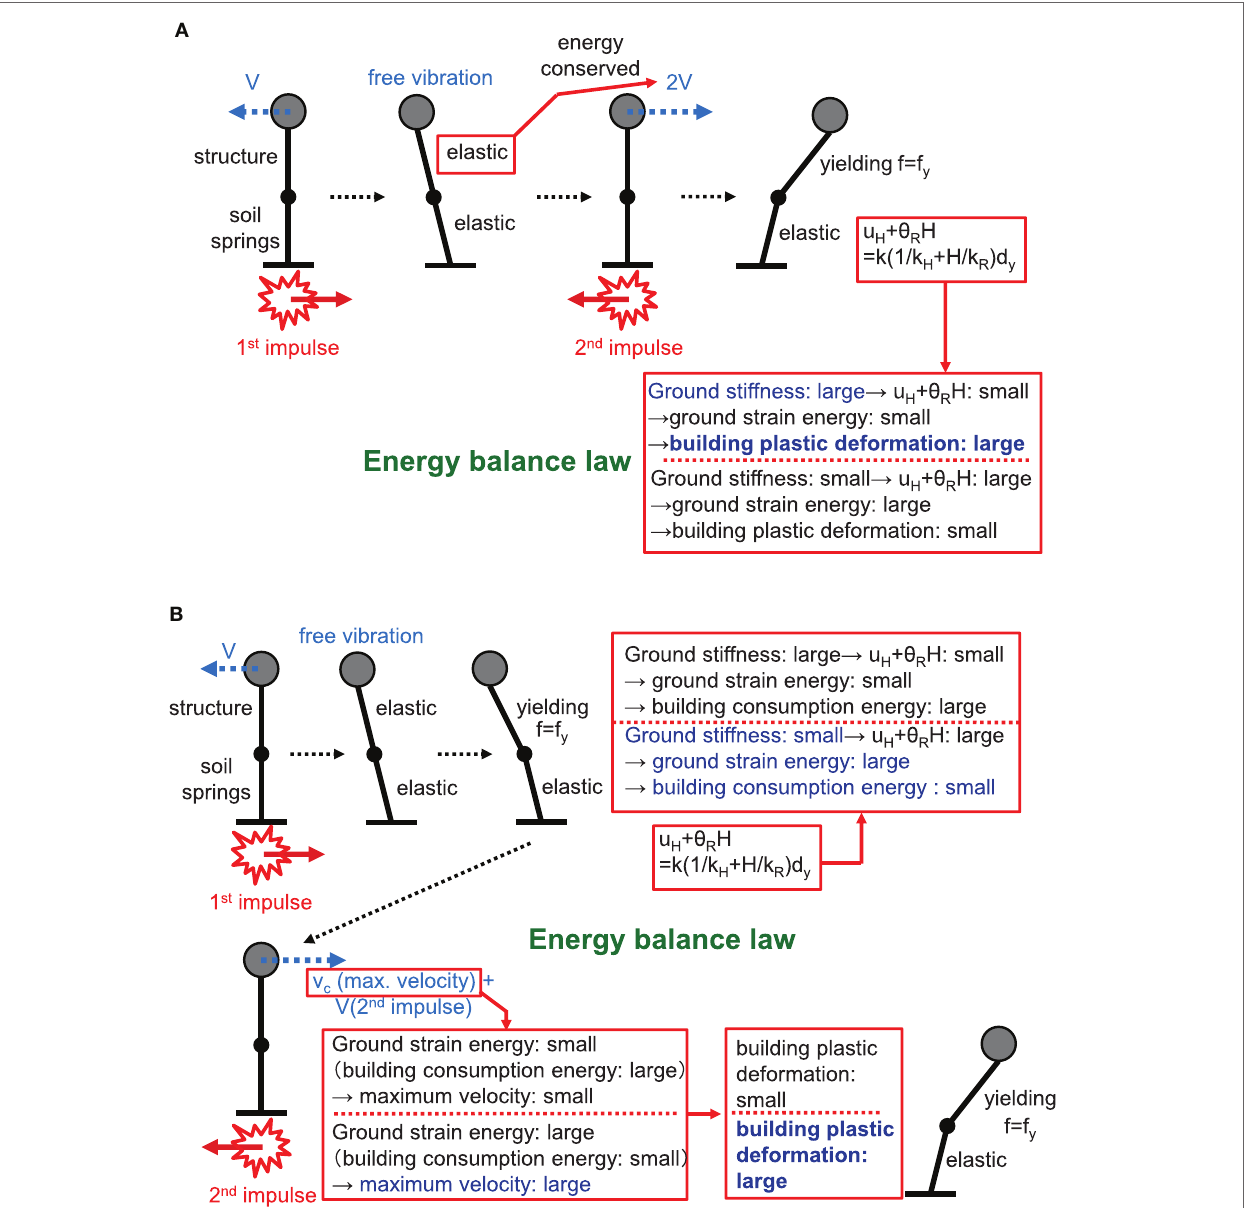
FigUre 10 | schematic diagram for better understanding of effect of soil type on superstructure plastic deformation: (a) small input level (case 2) and (B) large input level (case